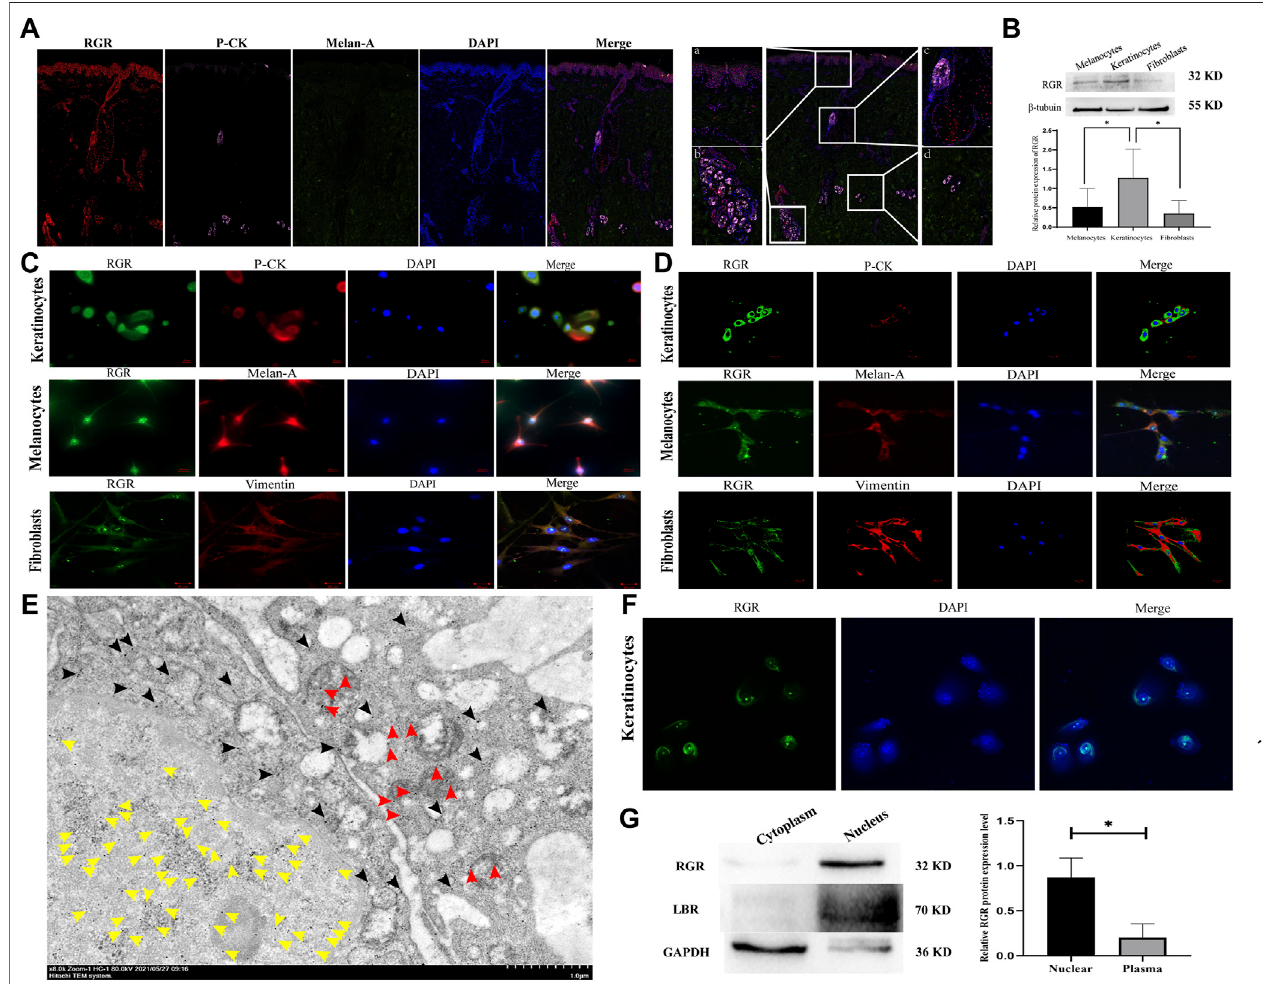
FIGURE 2 | RGR expression level and subcellular localization in human skin cells. (A) In normal human skin tissue, coimmunostaining of RGR (red) with the melanocytemarkermelan-A(green)andkeratinocytemarkerP-CK(pink)isshown.Scalebar=20 μ m.TheresultsshowedpositivestainingoftheRGRinthebasallayer of the skin, large sudoriferous glands, hair follicles, and eccrine glands. Scale bar = 200 μ m. (B) Representative expression of RGR and β -tubulin (loading control) in melanocytes, keratinocytes, and fi broblasts, as measured by the Western blot assay (anti-RGR antibody: a band of ~32 kDa; β -tubulin antibody: a band of ~55 kDa).TherelativeproteinlevelsofRGRand β -tubulinweremeasuredbyImageJsoftware(n=3independentexperiments). (C) Inculturedcells,thecolocalizationof the RGR(green) and melan-A (red) inmelanocytes,colocalization ofRGR(green) and CK-pan (red) inkeratinocytes, and colocalization ofRGR(green)and vimentin (red) in fi broblasts were detected by immuno fl uorescence double staining. Scale bar = 20 μ m. (D) Localization and expression of the RGR (green) in human skin cells (melanocytes, keratinocytes, and fi broblasts) were observed by a confocal microscope. Scale bar = 20 μ m. (E) IEM staining of the normal skin tissue. Representative protein A-gold probe represents RGR (RGR is mainly located in the nucleoplasm (yellow arrow) and mitochondria (red arrow) and scattered in the cytoplasm and other organelles (black arrow)). Scale bar = 1 μ m. (F) Representative expression of RGR (green) in the membrane and nucleus of human keratinocytes was observed